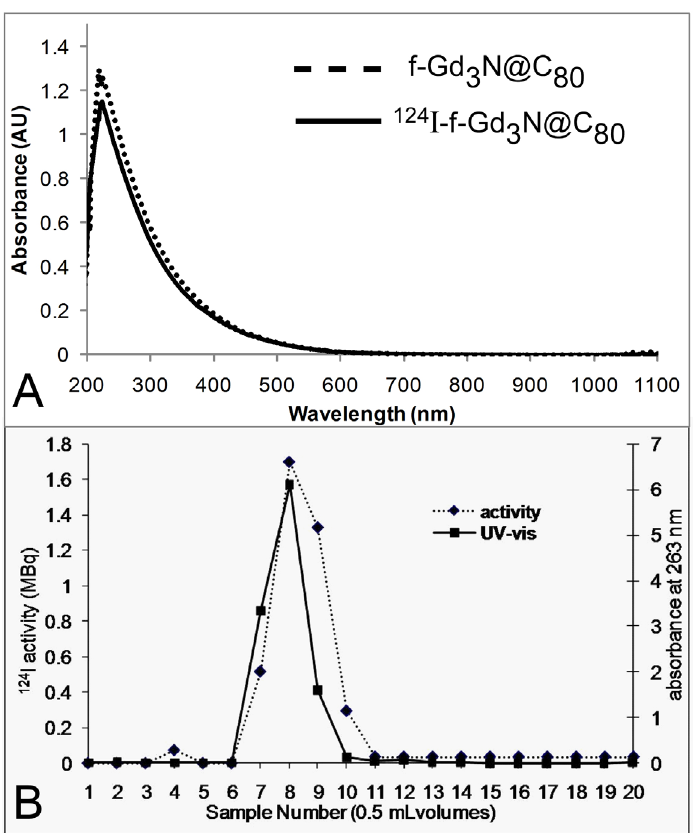
Figure 4. Analysis of 0.5 mL fractions collected post iodination during elution through the desalting column by UV absorption (solid line—right axis) and activity measurements (dashed line—left